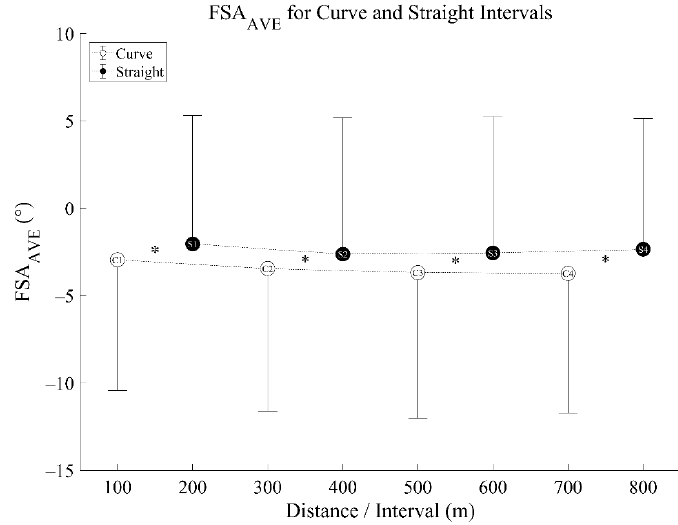
Figure 4. Foot Strike Angle Average (FSA AVE ) for curve and straight intervals—mean (circles) ± standard deviation bar (vertical lines—shown in one direction only). C1 signifies ‘Curve 1’, S1 signifies ‘Straight 1’. *—significant difference between curves and straights.